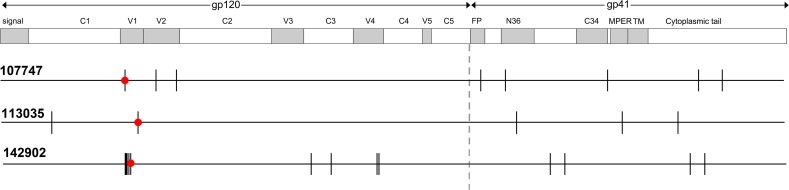
Diagram of sequence differences between pairs of neutralization-sensitive and -resistant Envs of CRF01_AE viruses.The locations of sequence differences between wildtype neutralization-resistant (wtR) and wildtype neutralization-sensitive (wtS) envelope genes from subjects 107747, 113035, and 142902 are indicated by vertical lines. The location of predicted N-linked glycosylation sites in the V1 domain that alter neutralization sensitivity is marked by red circles.